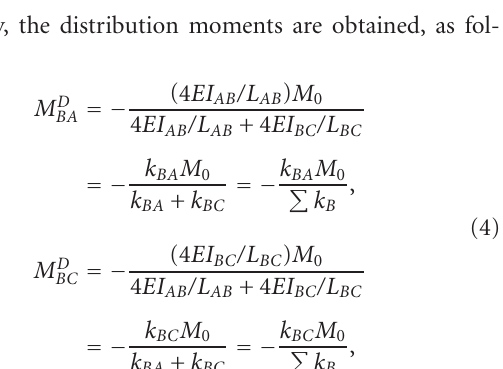
Figure 2: Free-body diagram of node B